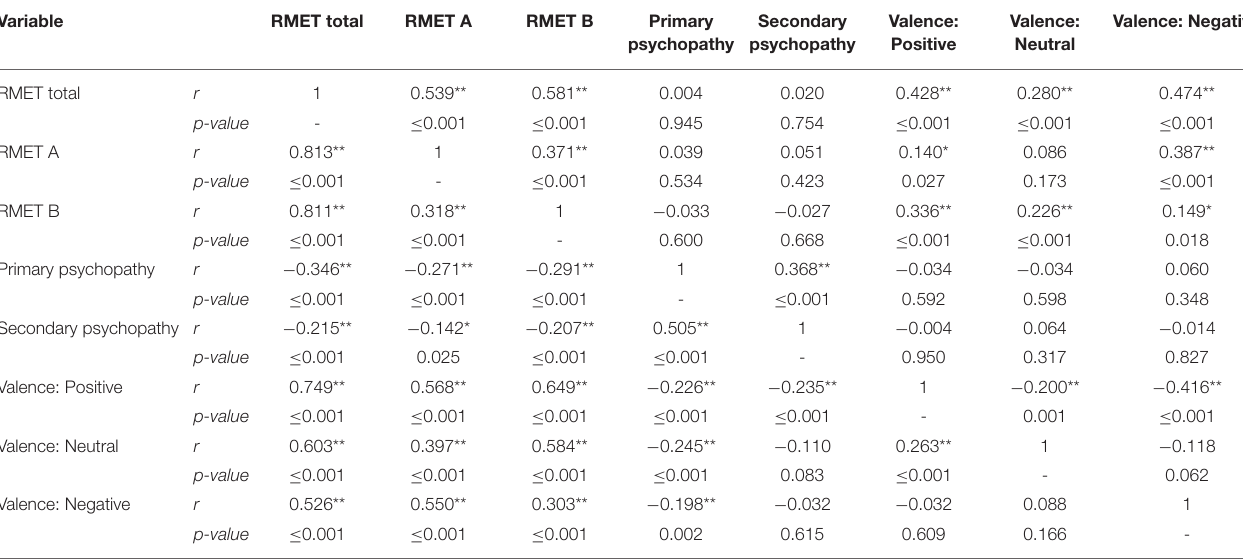
TABLE 3 | Correlation coefficients for the Upper quartile ( n = 250) and Lower quartile ( n = 250).